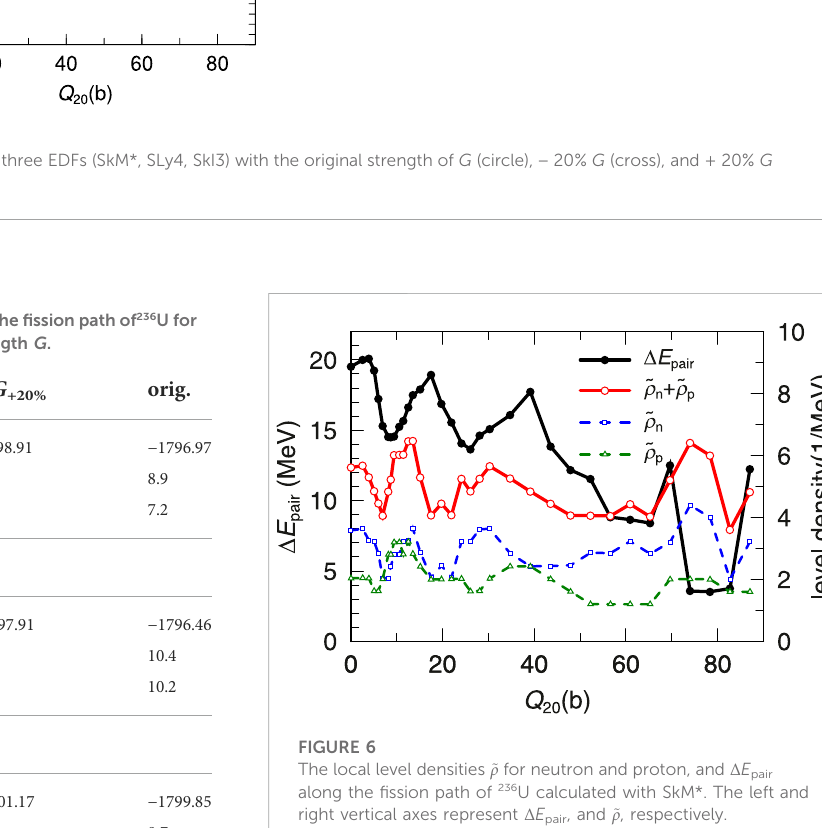
enhancement of the pairing strength leads to better